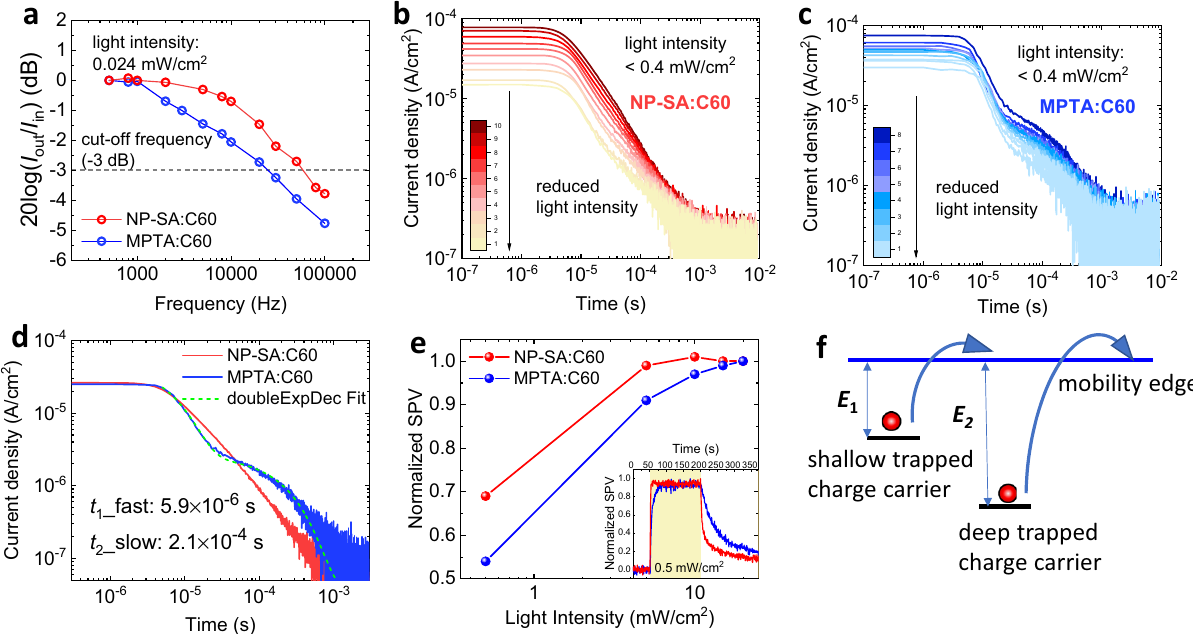
Fig. 2 Low-light illumination photocurrent transients. a The bandwidth of frequency response at photocurrent density of 2.7 µ A/cm 2 with the light intensity of 0.024 mW/cm 2 at 0 V. b NP-SA:C 60 device photocurrent transient measured by charge extraction (CE) at 0 V. c MPTA:C 60 device photocurrent transient measured by CE at 0 V. d A comparison of current transients measured at 0.5 mW/cm 2 . The photocurrent transient of MPTA:C 60 is fi tted with a double exponential decay function (green dash line). e Light intensity dependent SPV magnitude for NP-SA and MPTA blends, normalized to the SPV at the maximum light intensity. The normalized SPV signal during one illumination cycle at the lowest light intensity is shown in the inset. f Schematic demonstration of charge extraction of shallow and deep trapped charge